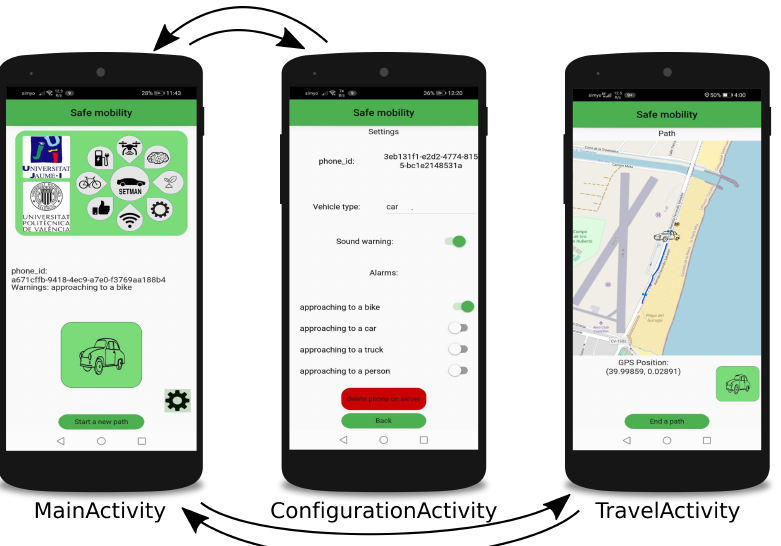
Figure 3. Available activities for the developed Android